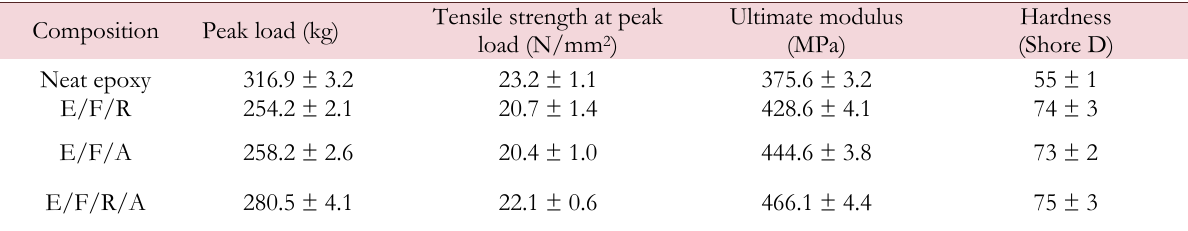
Table 8: Tensile test results of hybrid composites.